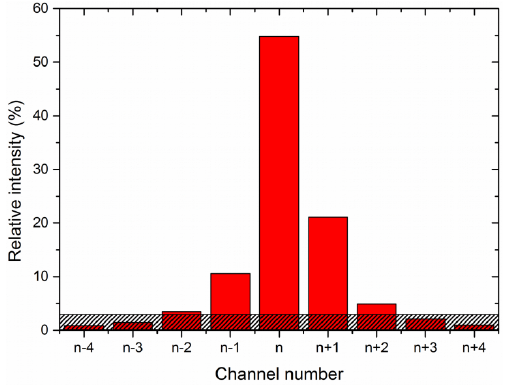
Figure 3. Results of the laboratory characterization of the optical crosstalk within the MAPMT of PHIPS-HALO. The manufacturer- given electronic crosstalk between adjacent detectors of 3% is in- dicated by the shaded area. The deduced optical crosstalk between adjacent detectors is 10% to the left and 20% to the right side, in- dicating a slight misplacement of the fibre coupler with respect to the